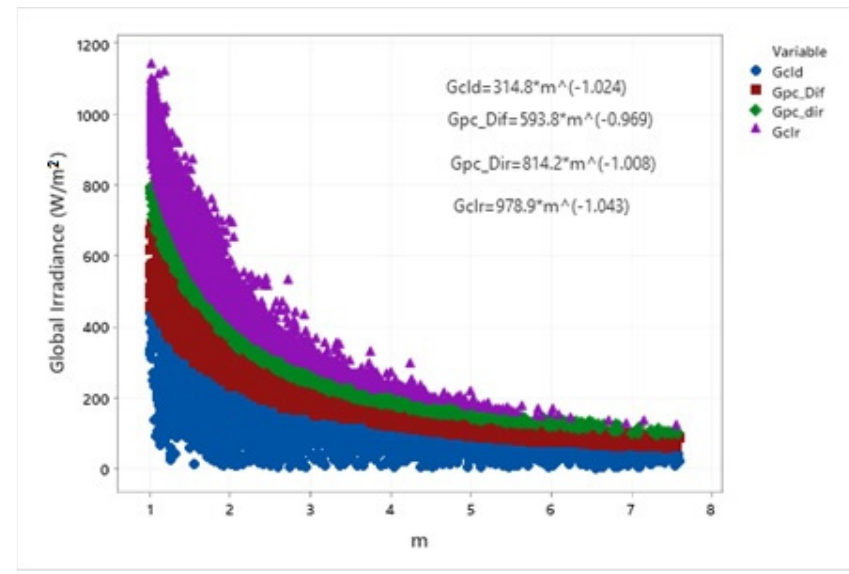
Figure 20. Relationship of global irradiance in W/m 2 and optical air mass (m).